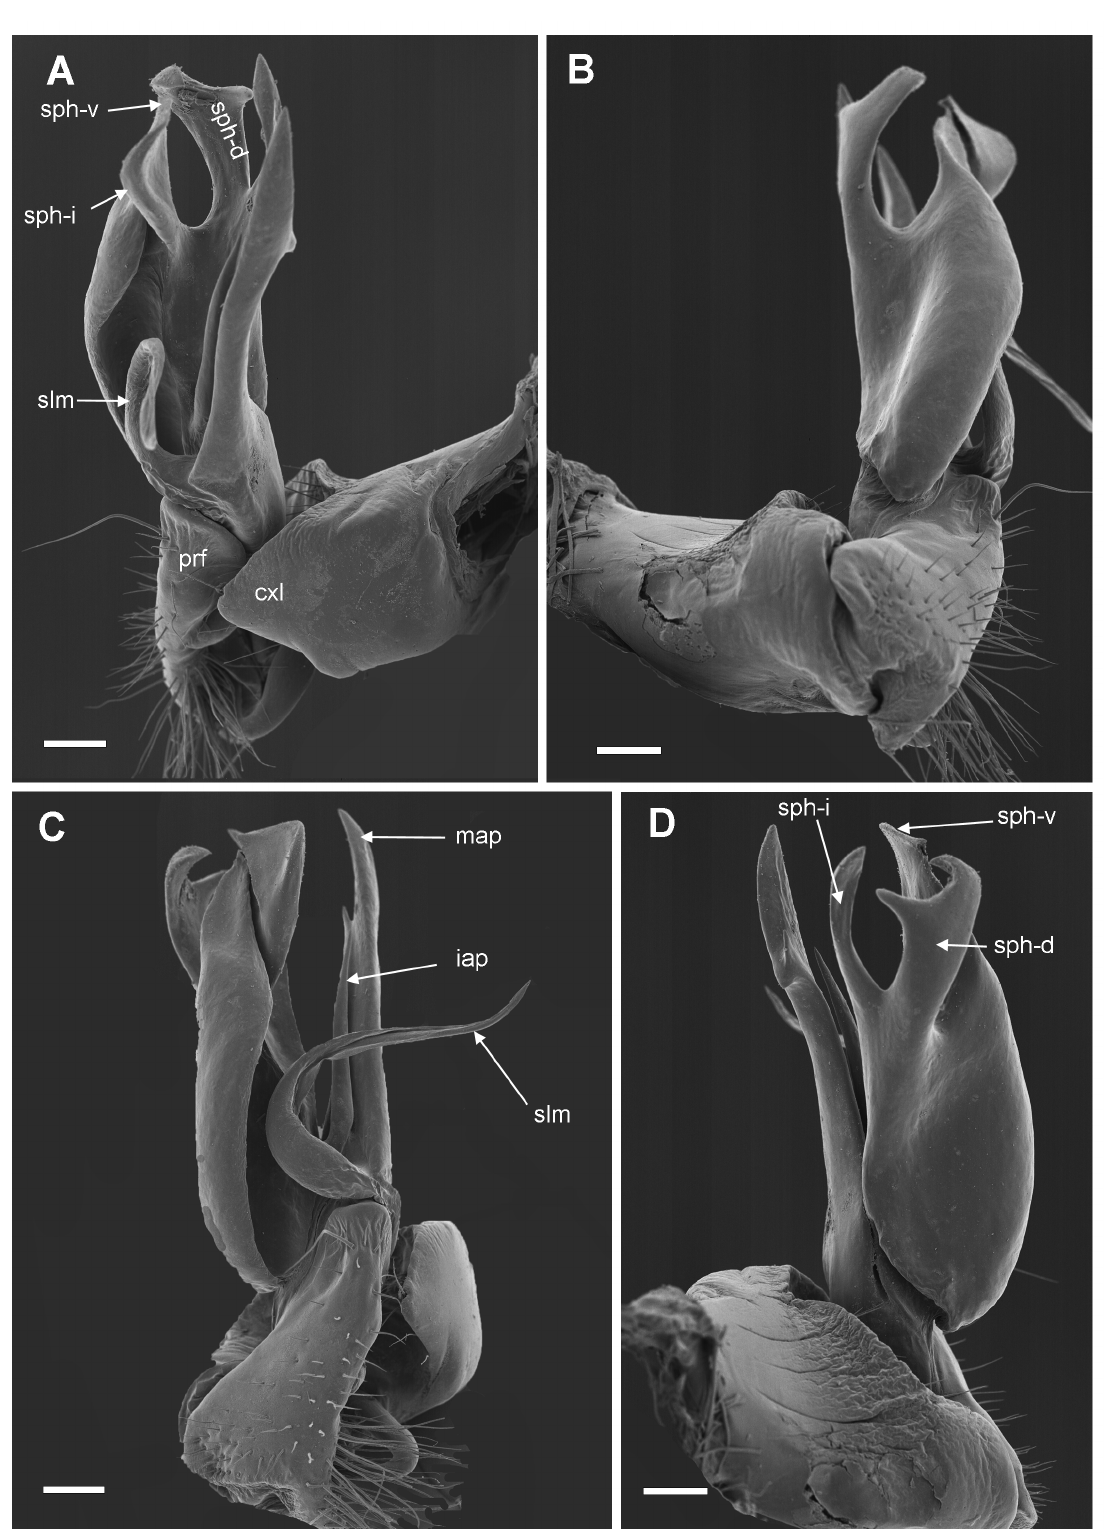
Fig. 17. Eviulisoma kalimbasiense sp. nov., paratype, right gonopod. A . Mesal view. B . Lateral view. C . Ventral view. D . Dorsal view. Abbreviations: cxl = coxal lobe; iap = intermediate acropodital process; map = mesal acropodital process; prf = prefemoral part; slm = solenomere; sph-d , sph-i , sph-v = dorsal, intermediate and ventral lobes of solenophore. Scale bars: 0.1